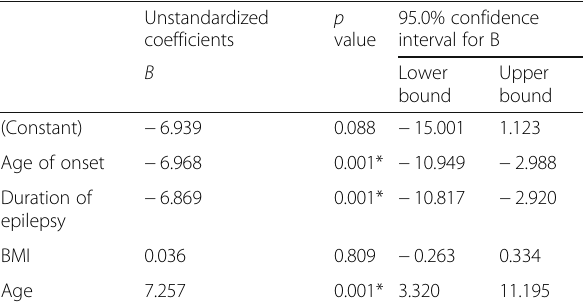
Table 8 Multivariate regression model assessing predictors of AHI in adults with refractory